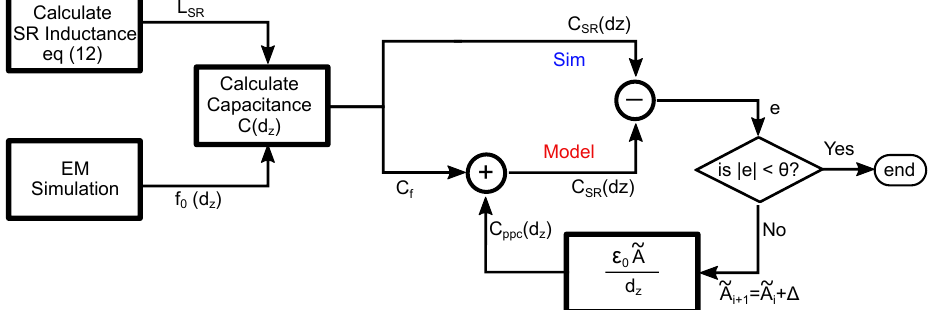
Figure 10. Flowchart for the proposed additional capacitance model where f 0 ( d z ) is the resonant frequency and C SR ( d z ) is the SR total capacitance, both expressed as a function of d z , and e is the error between the model and simulation results. ∆ is the step increment of the fitted variable ˜ A , and θ is the desired max error.